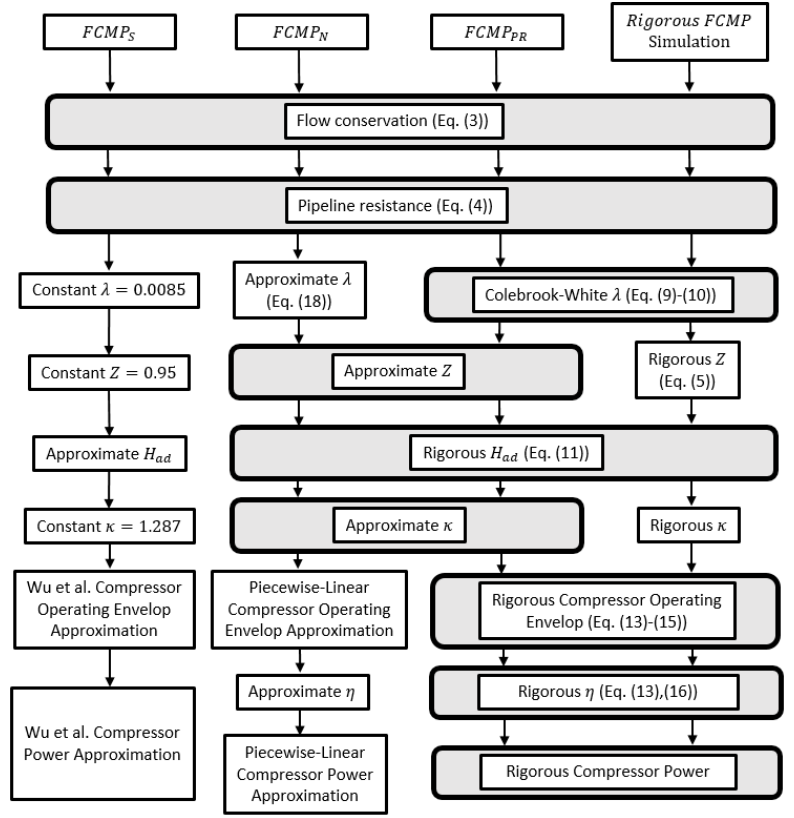
Figure 15. Flow chart detailing the components of each FCMP model applied in the case study, and the rigorous simulation